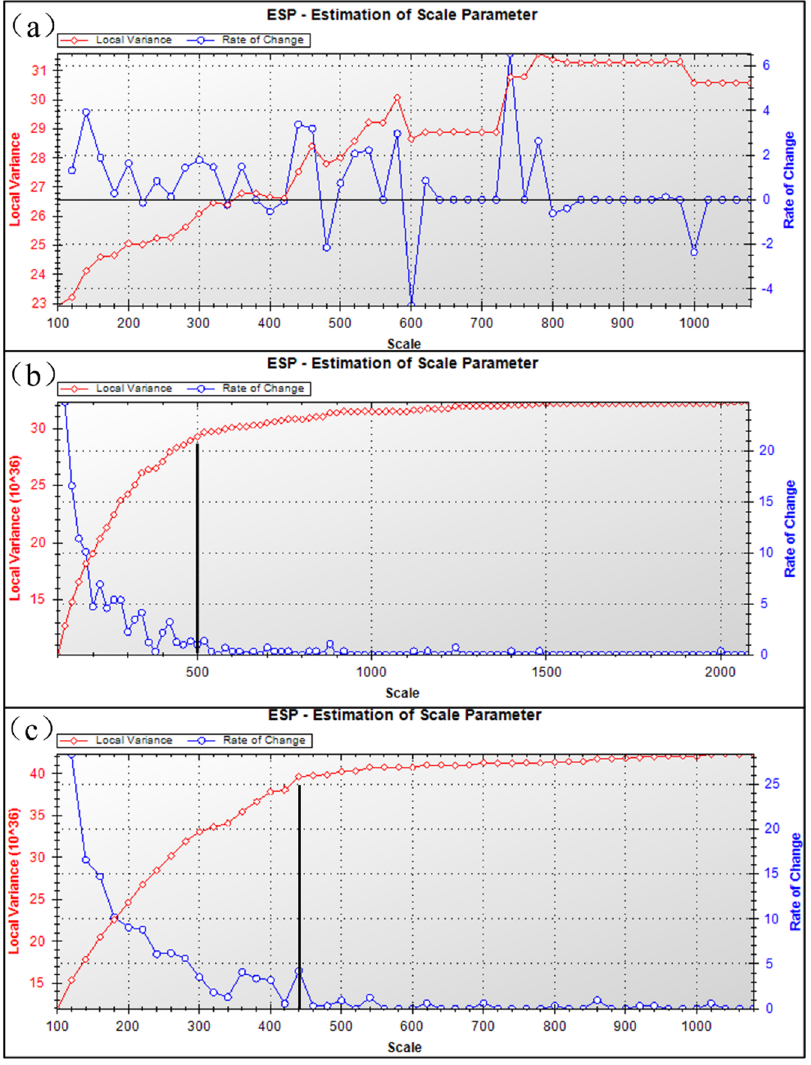
Figure 10. DOM segmentation scale. ( a ) represents the local variances of the segmentation object were counted to obtain the LV − ROC curve. ( b ) represents the LV − ROC curve obtained after the elevation was added. ( c ) represents the LV − ROC curve obtained after the slope was added.